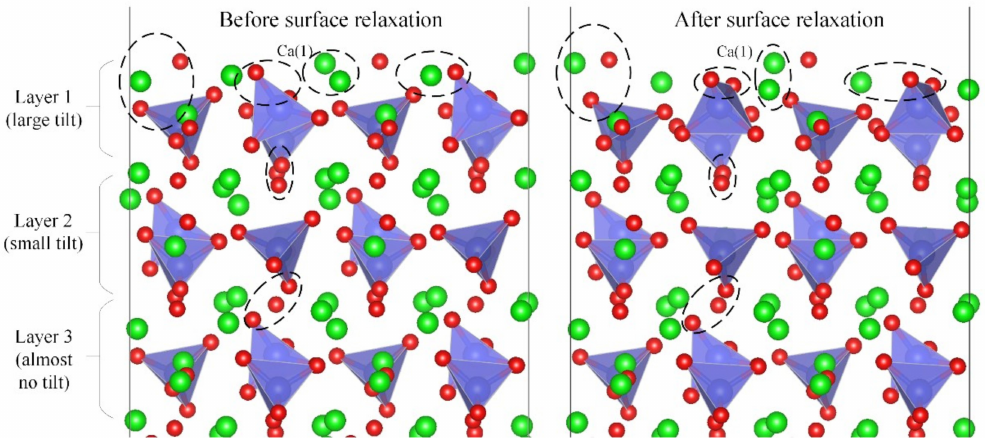
Figure 1. Near-surface structures of M3-C 3 S (111) before and after relaxation. Green spheres indicate Ca; red spheres indicate O; blue spheres indicate Si in the center of the SiO 4 tetrahedron; dashed ellipses indicate several changes before and after surface